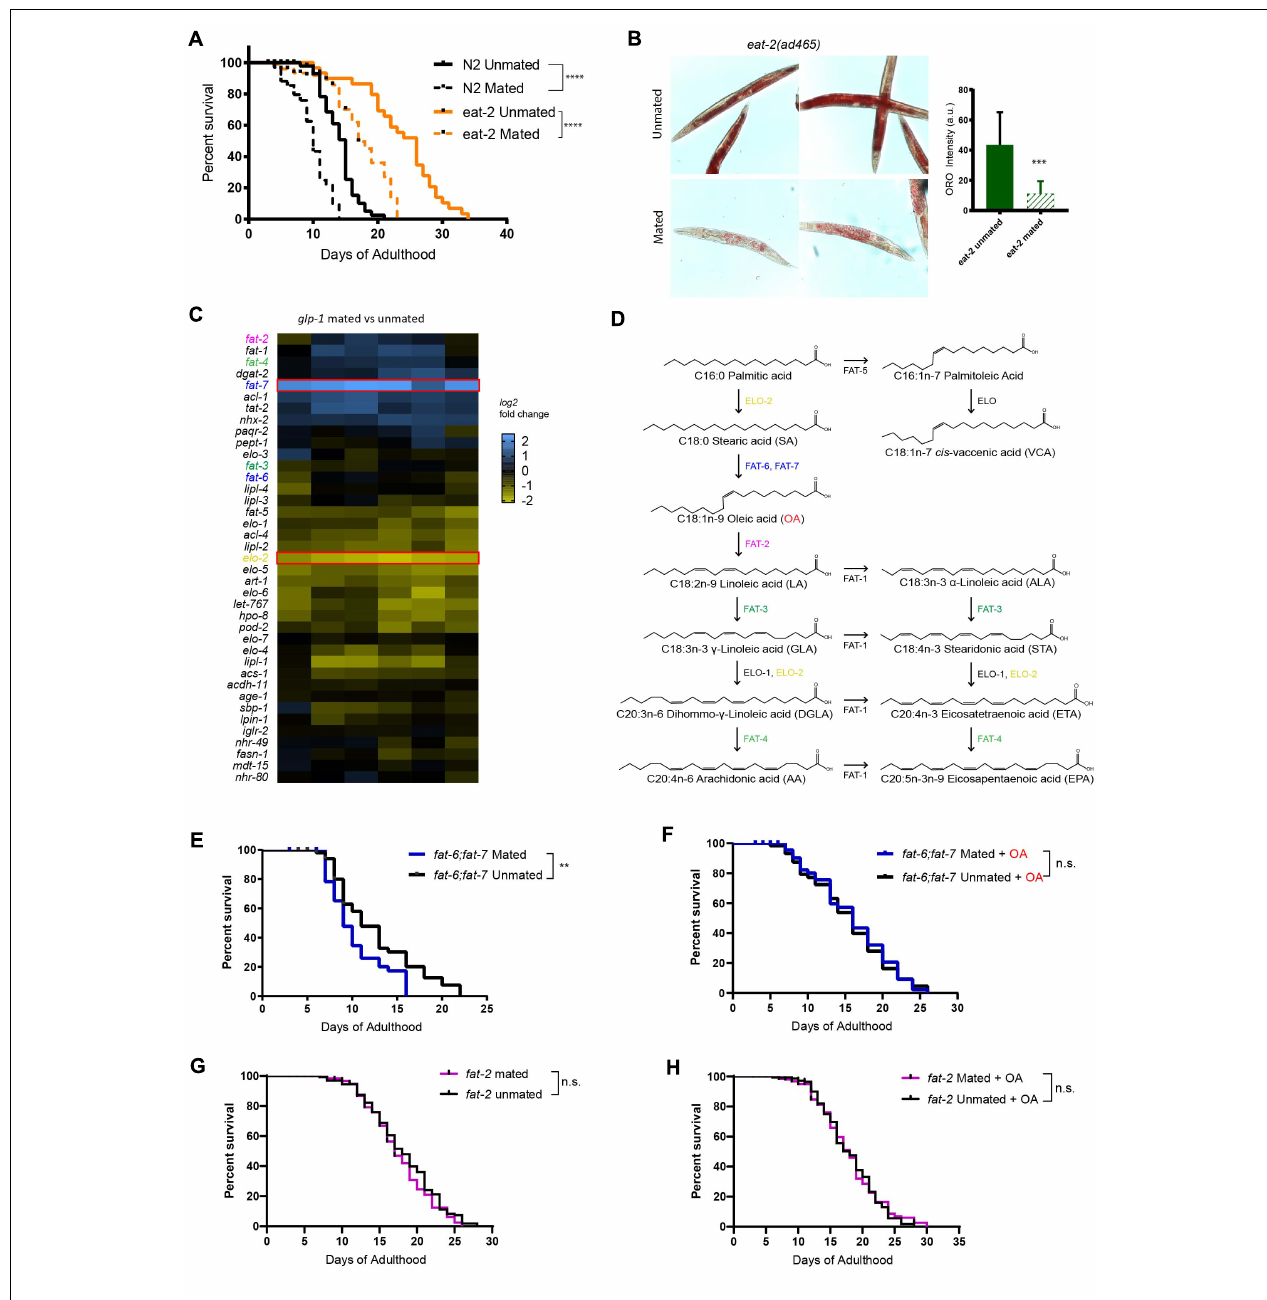
FIGURE 1 | Endogenous oleic acid protects worms from mating-induced death. t -test, * p < 0.05, ** p < 0.01, *** p < 0.001, **** p < 0.0001 for all graphs. For all the lifespan assays performed in this study, Kaplan–Meier analysis with log-rank (Mantel–Cox) test was used to determine statistical significance (lifespan of mated worms was always compared to unmated worms of the same genotype/treatment unless stated otherwise). Error bars represent SEM unless noted. n.s., not significant. a.u., arbitrary units. (A) Mated worms under dietary restriction live longer than those ad libitum despite extreme depletion of fat. N2 Unmated: 14.0 ± 0.4 days, n = 50, N2 mated: 8.8 ± 0.4 days, n = 100, p < 0.0001; eat-2(ad465) unmated: 23.6 ± 1.1 days, n = 50, eat-2(ad465) mated: 15.1 ± 1.2 days, n = 100, p < 0.0001. (B) Mating induces significant fat loss in eat-2(ad465) hermaphrodites. Left: representative Oil Red O staining pictures; Right: quantification of Oil Red O staining. (C) Expression heatmap of genes related to fatty acid biosynthesis in mated C. elegans glp-1(e2141) hermaphrodites. (D) Pathway of de novo fatty acid synthesis in C. elegans , including molecular structure of each fatty acid. (E,F) Mutants that cannot synthesize oleic acid have dramatic lifespan loss after mating, and oleic acid supplementation fully rescues the mating-induced lifespan decrease fat-6;fat-7 unmated: 12.3 ± 0.7 days, n = 60; fat-6;fat-7 mated: 9.6 ± 0.4 days, n = 100, p = 0.0059; fat-6;fat-7 unmated + oleic acid: 15.1 ± 0.8 days, n = 60; fat-6;fat-7 mated + oleic acid: 15.5 ± 0.8 days, n = 100, p = 0.7648. (G,H) Mutants that contain excess endogenous oleic acid are protected from lifespan loss after mating. fat-2 unmated: 18.1 ± 0.4 days, n = 175; fat-2 mated: 17.1 ± 0.4 days, n = 193, p = 0.2178; fat-2 unmated + oleic acid: 18.0 ± 0.4 days, n = 173; fat-2 mated + oleic acid: 18.0 ± 0.4 days, n = 215, p = 0.7598.